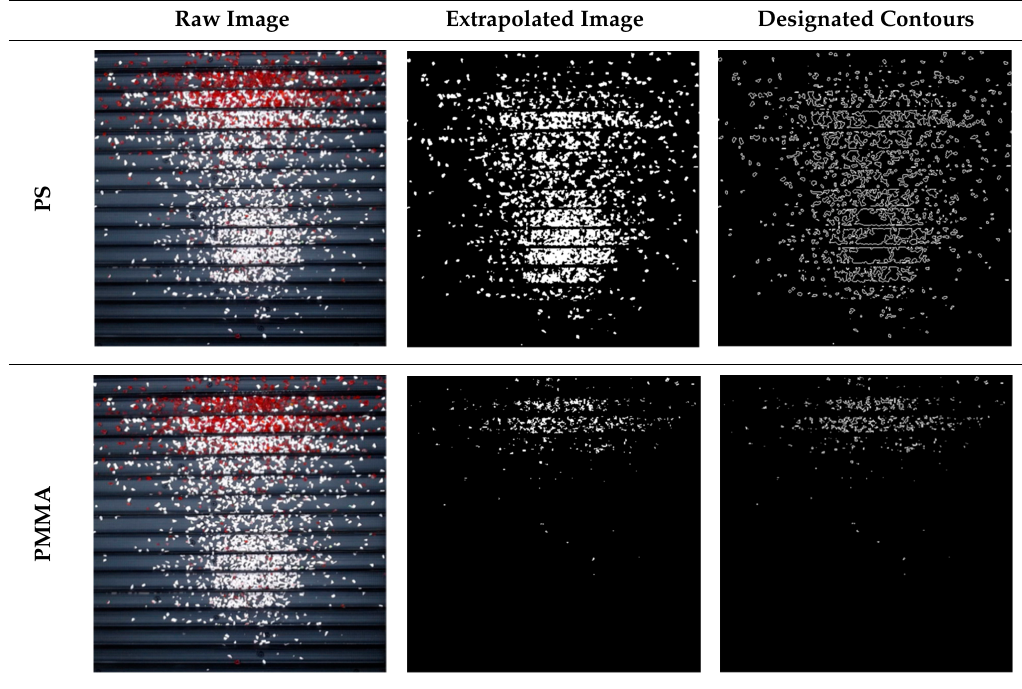
Figure 11. Results of processing the raw image ( a ); percentage material content in each ROI ( b ) and percentage material content related to total amount of each material ( c ) for the corona charging mode.